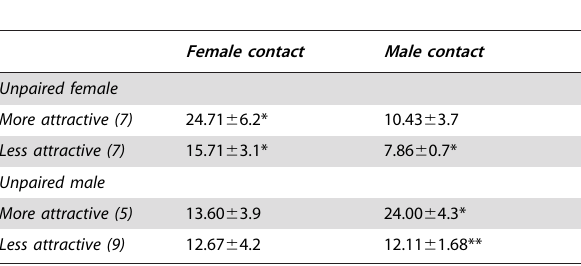
Table 1. Mean 6 SE female and male contact initiations/h in presence of an unpaired bird that was either more or less attractive than the focal bird.